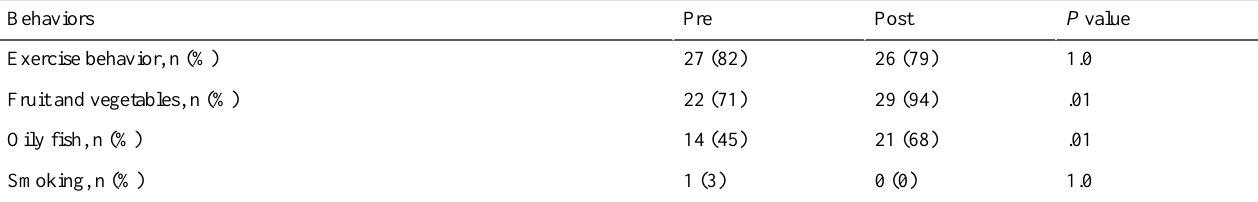
Table 3. Changes in health behaviors